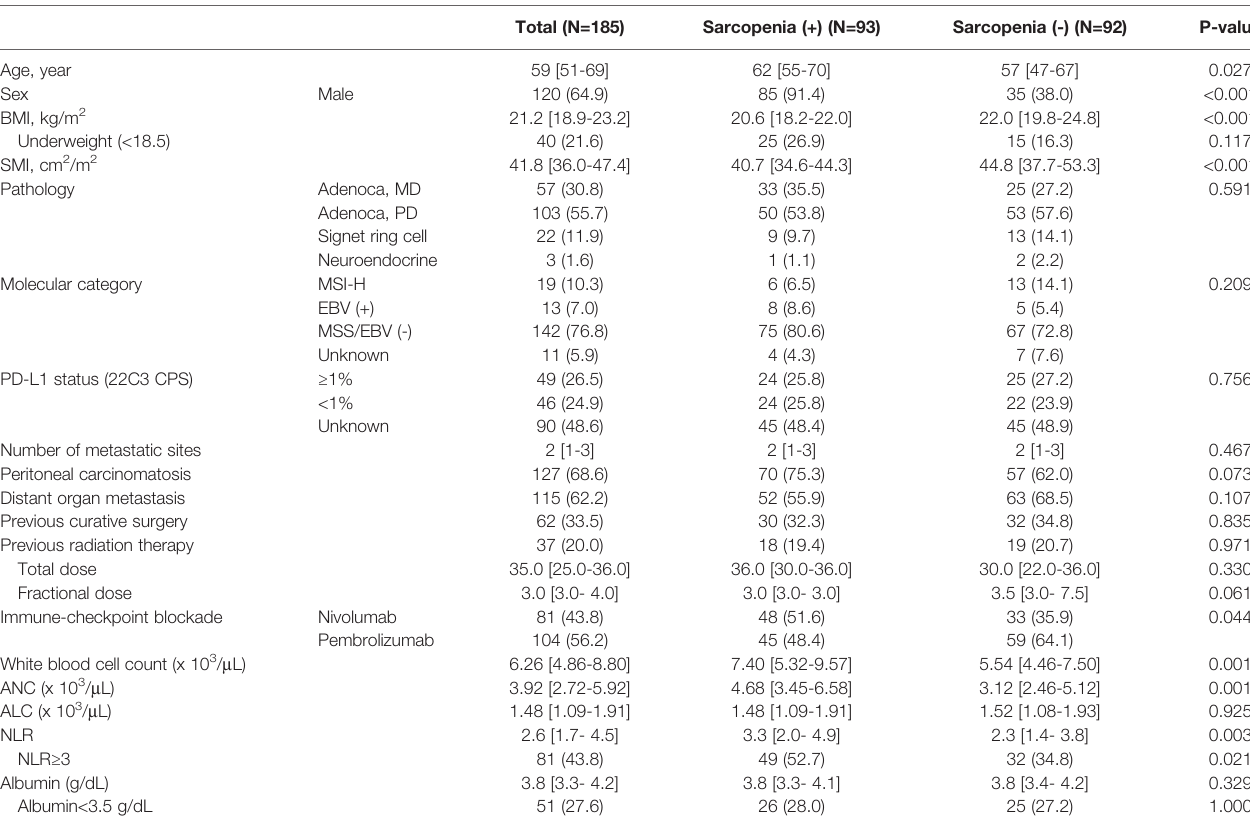
TABLE 1 | Patient characteristics strati fi ed by sarcopenia